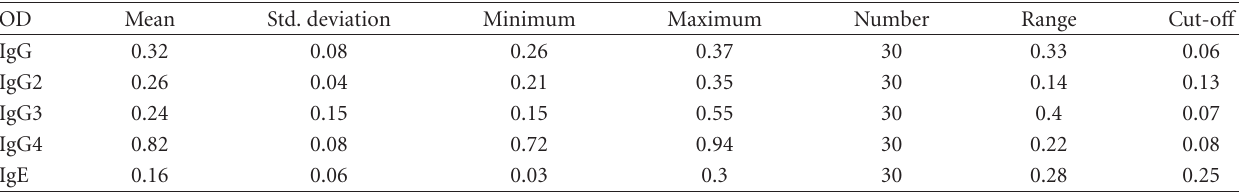
Table 6: The mean OD values of IgG class and subclass responses of 30 naturally infected hyadid patients against cattle cystic crude fluid